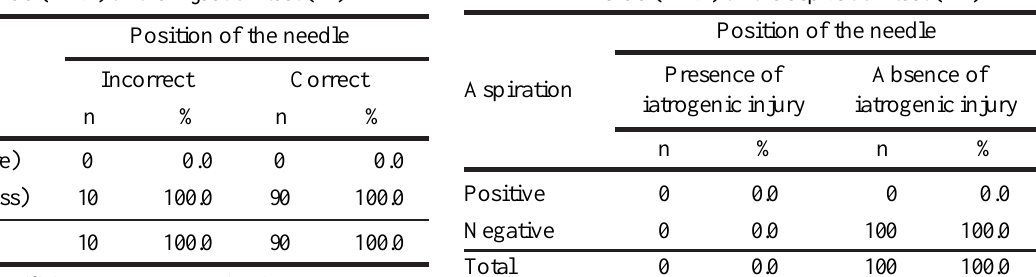
TABLE 3 - Calculation of sensitivity, specificity, positive TABLE 4 - Calculation of sensitivity, specificity, positive predictive value (PPV) and negative predictive predictive value (PPV) and negative predictive value (NPV) of the aspiration test (AT)